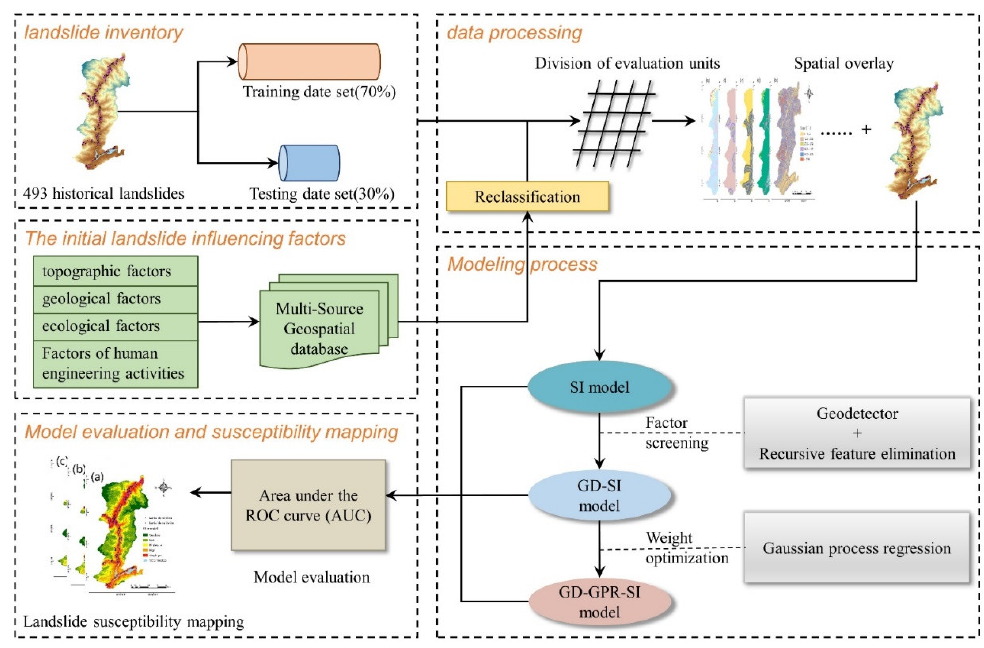
Figure 4. Methodological flowchart.